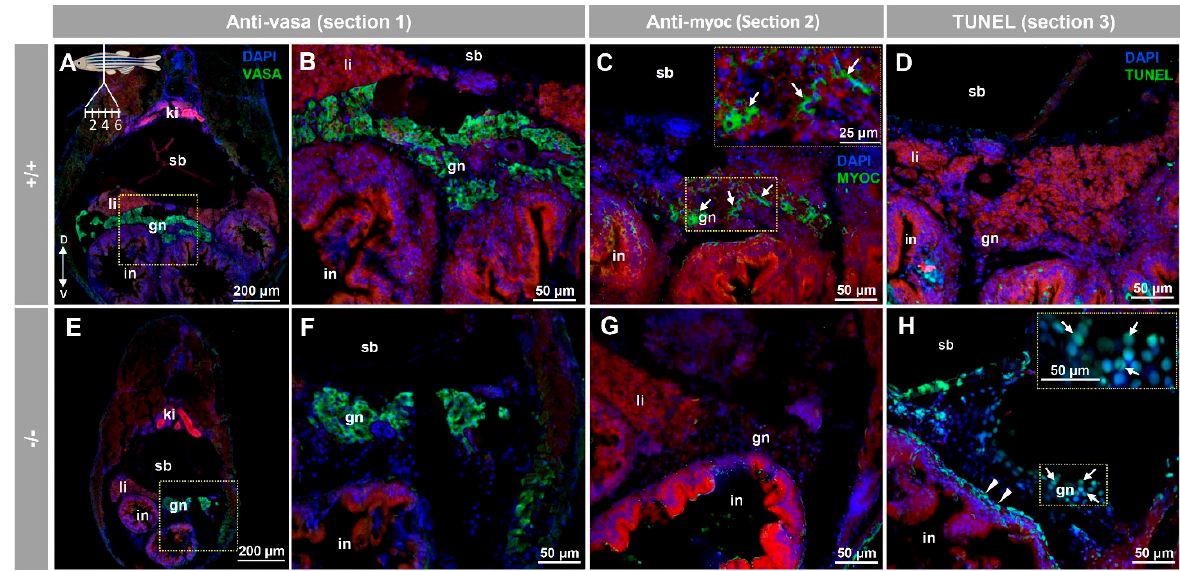
Figure 9. Myocilin expression and apoptosis analysis in the immature (28 dpf) gonad of zebrafish KO for myoc . Analyses were performed on three consecutive tissue sections (1 to 3, upper left insert in panel A ). Vasa immunolabeling was carried out on section one (green, A , B , E , F ). Areas indicated by yellow rectangles in ( A , E ) are magnified in ( B , F ), respectively. Tissue section two was incubated with an anti-myocilin (TNT) antibody (green signals) to localise myocilin expression ( C , G ). Apoptosis was assessed in tissue section three using terminal dUTP nick-end labeling (TUNEL) of fragmented DNA ( D , H ). Arrows in ( C ) indicate myocilin immunoreactivity. Arrows and arrowheads in H indicate TUNEL-positive cells in gonadal tissue and in the outer intestinal wall, respectively. Blue and red signals correspond to DAPI nuclear staining and tissue autofluorescence, respectively. gn: gonad. in: intestine. ki: kidney. li: liver. sb: swimbladder. The vertical double arrow in ( A ) indicate de dorsovental axis (D: dorsal; V: ventral). The images are representative of the results observed in four fishes of each genotype. Negative controls of the juvenile gonad are shown in Figure S10 (tissue sections four to six).